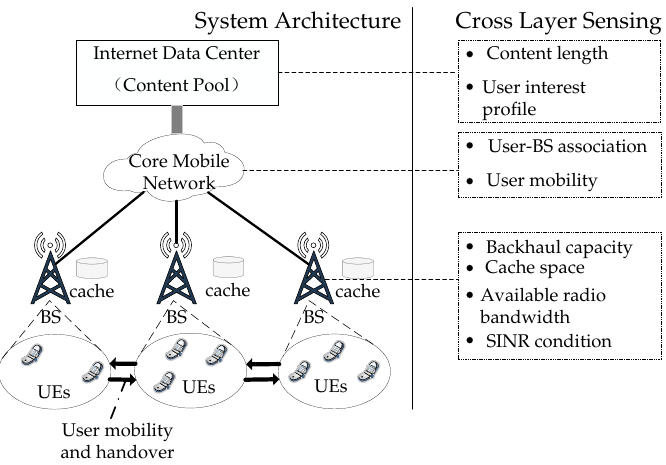
Figure 1. Illustration of the system